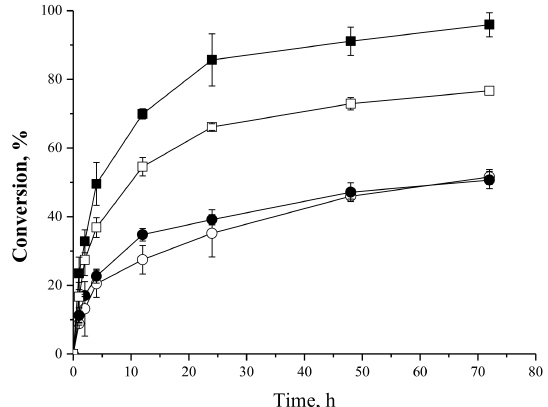
Figure 8. Oleic acid conversion as a function of time for syntheses of fructose oleate in tert -butyl alcohol as solvent at 45 ◦ C, 72 h reaction and 250 rpm stirring. Molar ratio oleic acid/fructose of 1:2 (oleic acid initial concentration 25 mM, fructose initial concentration 50 mM) using IMMCALB-T2-350 ( (cid:4) ) and PFL-octyl-silica ( ). Molar ratio oleic acid/fructose of 2:1 (oleic acid initial concentration 50 mM, (cid:35) fructose initial concentration 25 mM) using IMMCALB-T2-350 ( (cid:3) ) and PFL-octyl-silica ( ). For all assays 0.5 g of derivative and 1.5 g of molecular sieves were